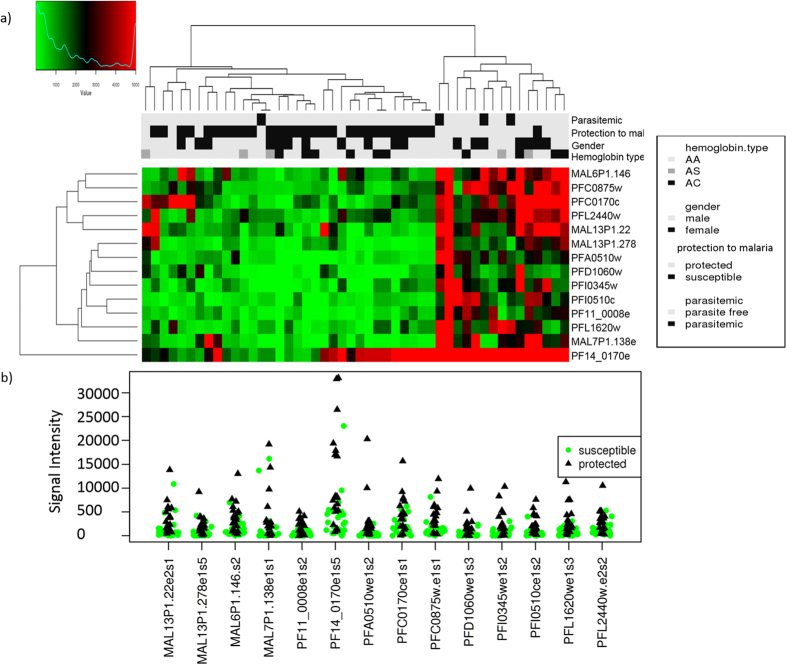
Antibody response against fourteen P. falciparum proteins found to discriminate between protected (n = 19) and susceptible (n = 29) children with high accuracy (AUC range = 0.8–0.9).(a) Heatmap of antibody reactivity measured at baseline before the malaria season. Antibody reactivity profiles of protected and suceptible children form distinct clusteres. (b) Stripchart representing the antibody signal intensities in protected and susceptible children.